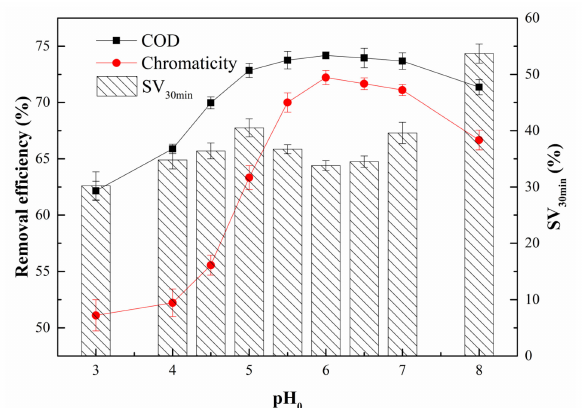
Figure 3. The effect of pH 0 on the removal efficiency when PFS is used as a